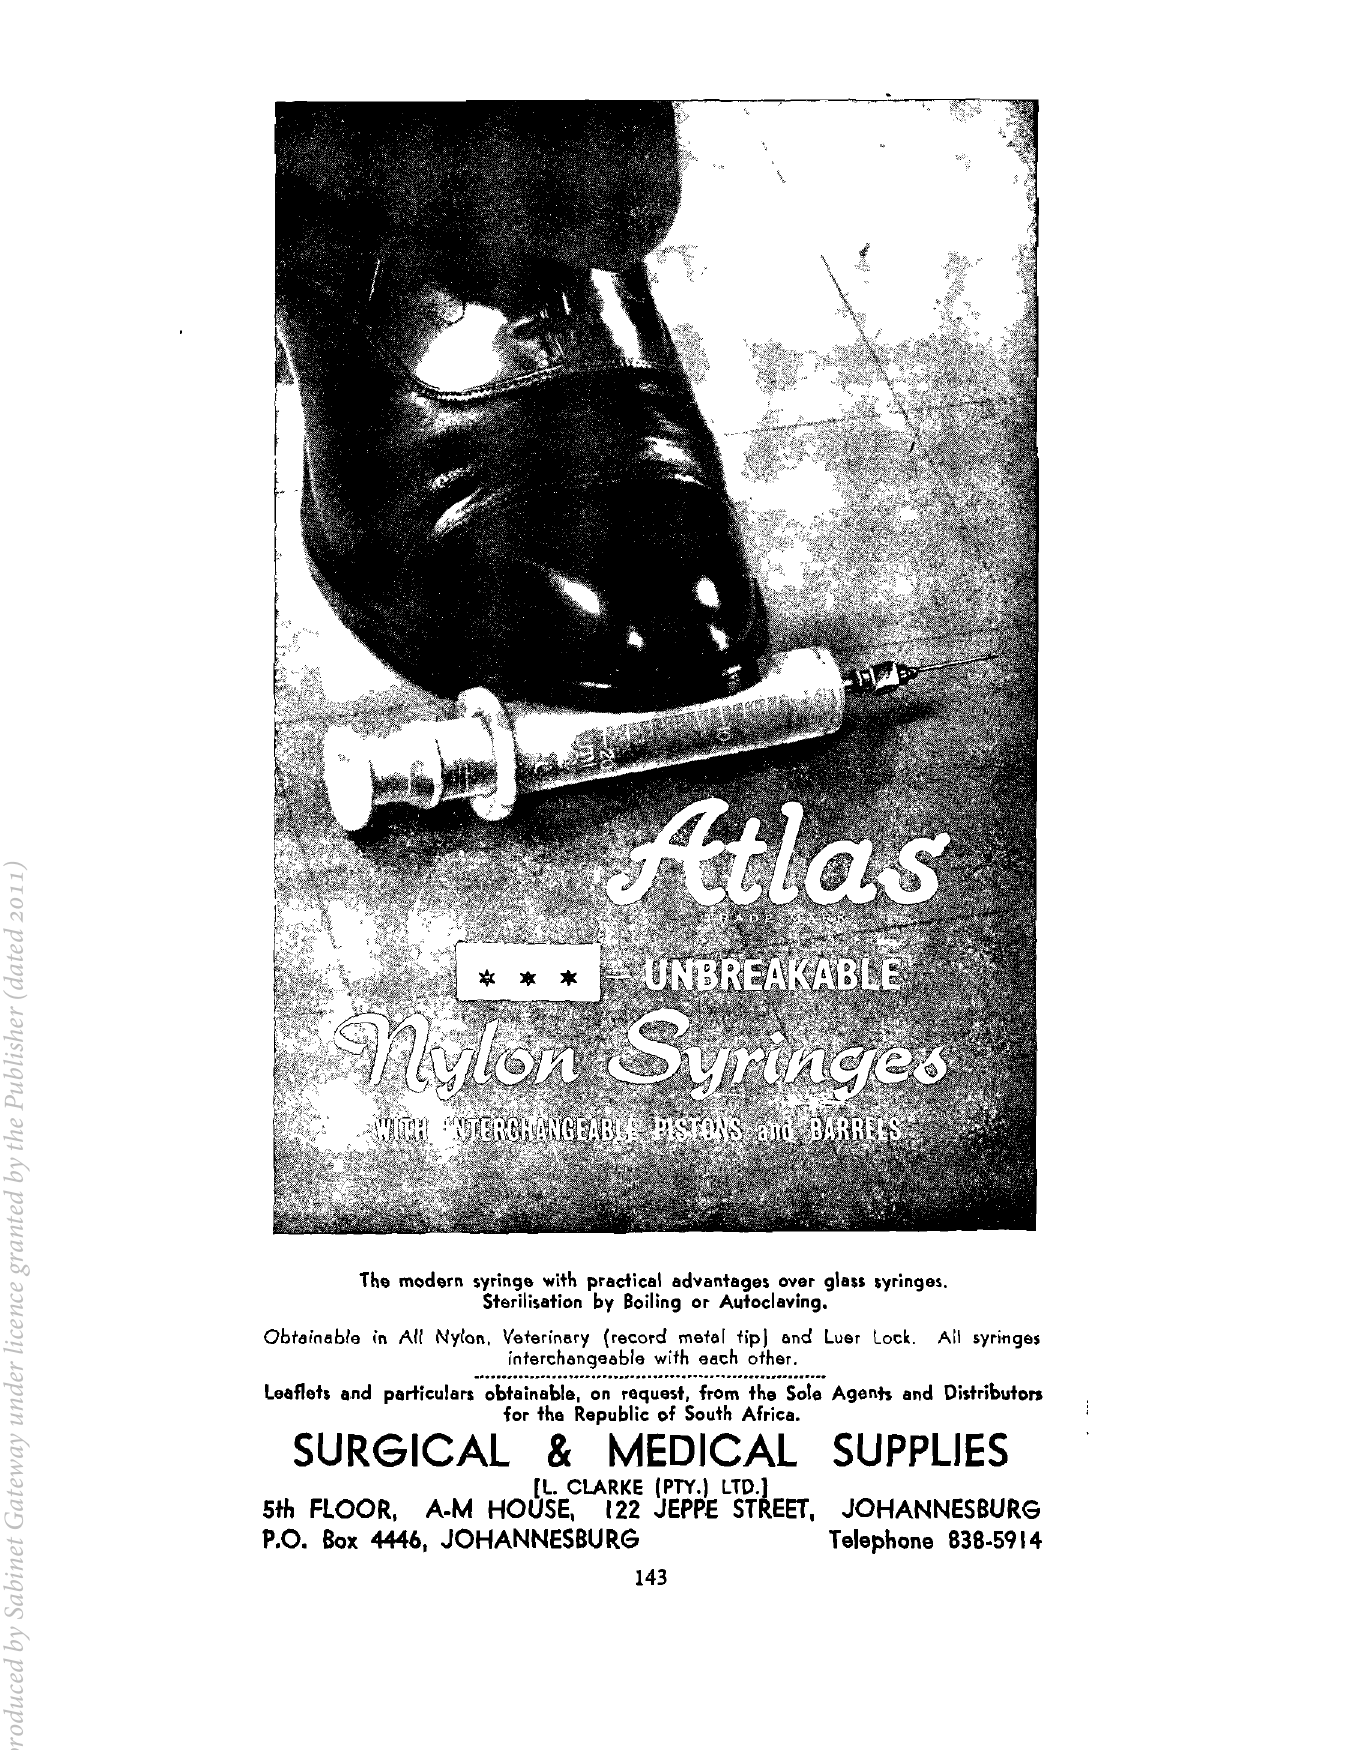
Obtainable in AI! Nylon. Veterinary (record metol tip) ond Luer lock. All syringes interchangeable with each